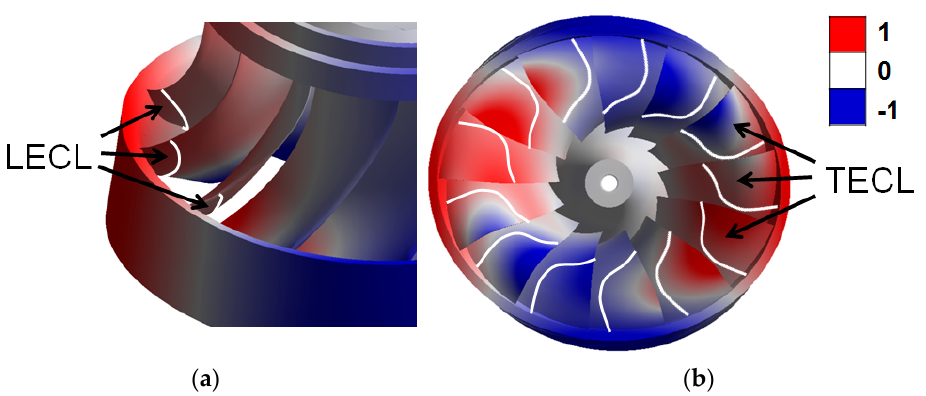
Figure 18. ( a ) Lateral view of the 2ND deformation in the area with leading edge cavitation; ( b ) lateral view of the 2ND deformation in the area with trailing edge cavitation.